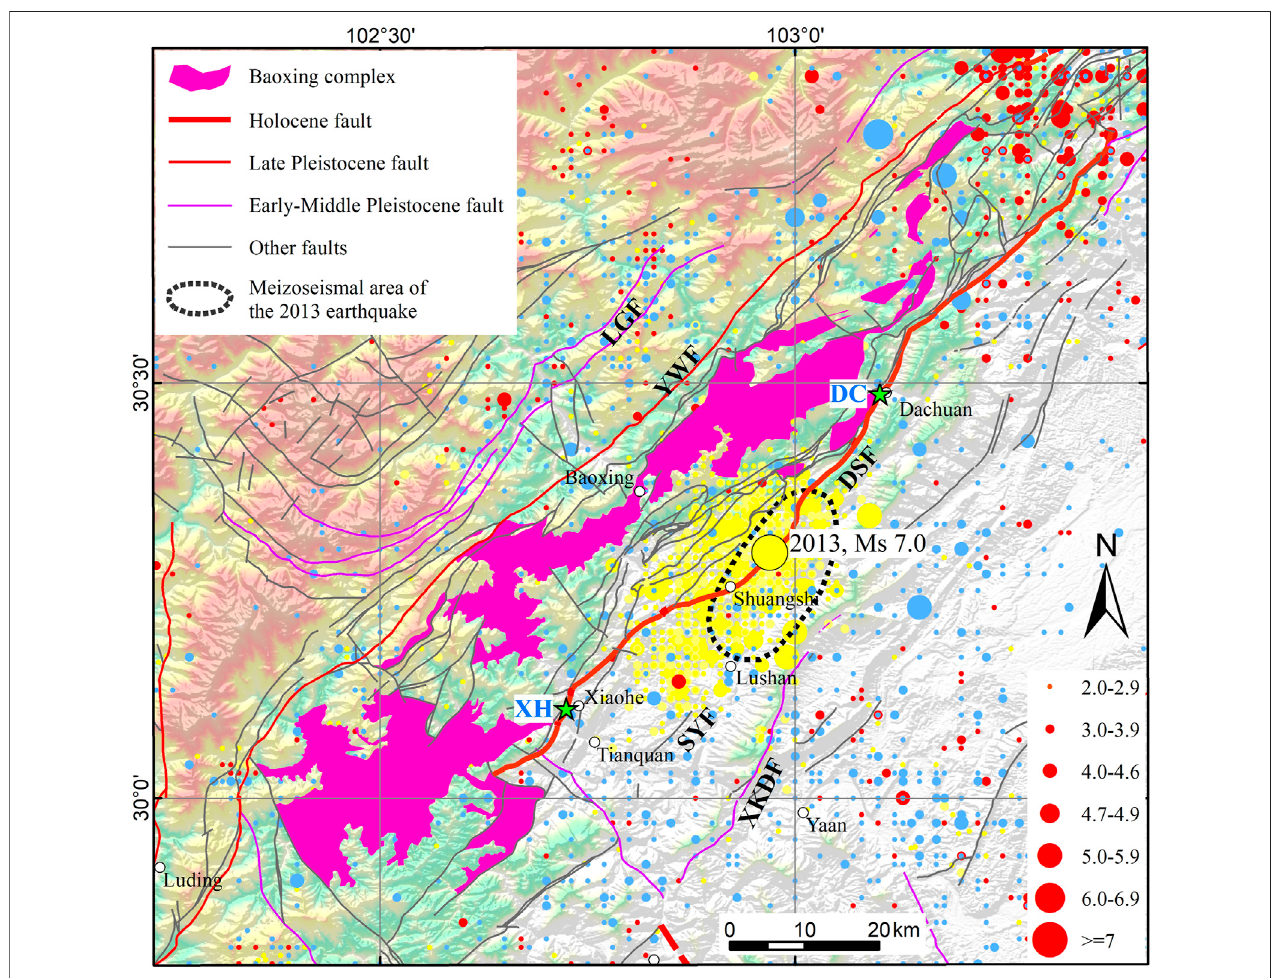
FIGURE 2 | Map showing the topographic distribution of the southern segment of the LFZ and earthquake epicenters ( M ≥ 2.0). The blue circles denote events before the 2008 Wenchuan earthquake, red circles denote events after the 2008 Wenchuan earthquake but before the 2013 Lushan earthquake, and yellow circles denote relocated aftershocks of the 2013 Lushan earthquake. Fault names: XKDF: Xinkaidian and SYF: Shiyang (see Figure 1 for other symbolic meanings).